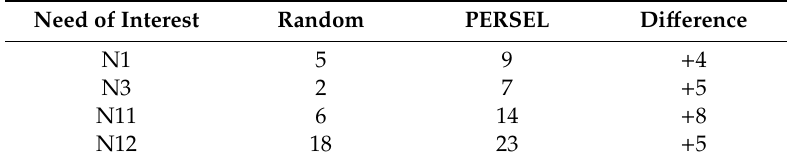
Table 7. Number of solutions (referred to the needs of interest) generated by the random user sample vs. the PERSEL